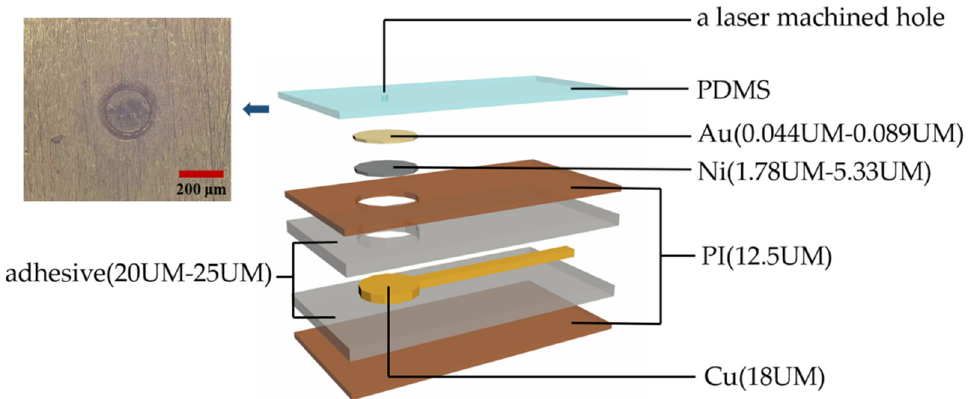
Figure 1. Soft neural electrode based on FPC technology and PDMS encapsulation layer. The PDMS layer serves as an intermediate layer which can reduce the mechanical mismatch between the flexible polyimide layer and neural tissue.